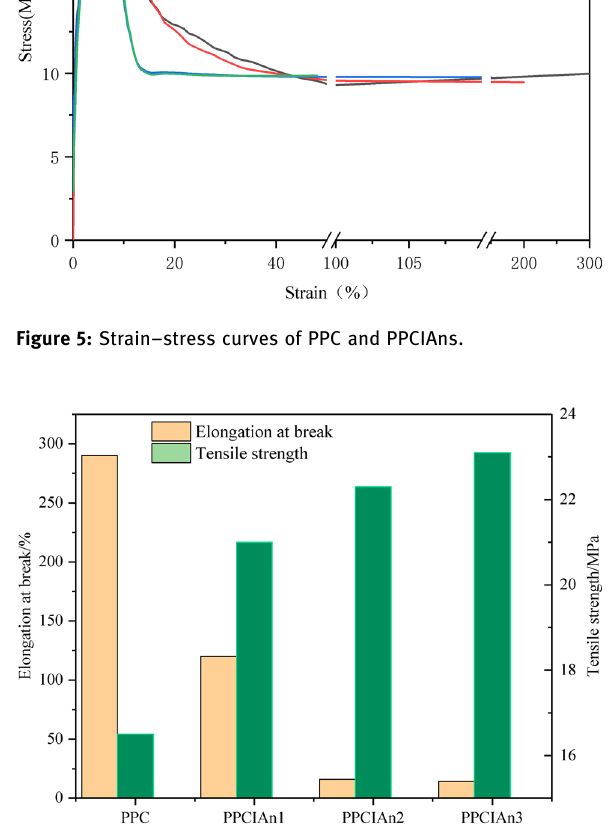
Figure 6: Mechanical properties of PPC and